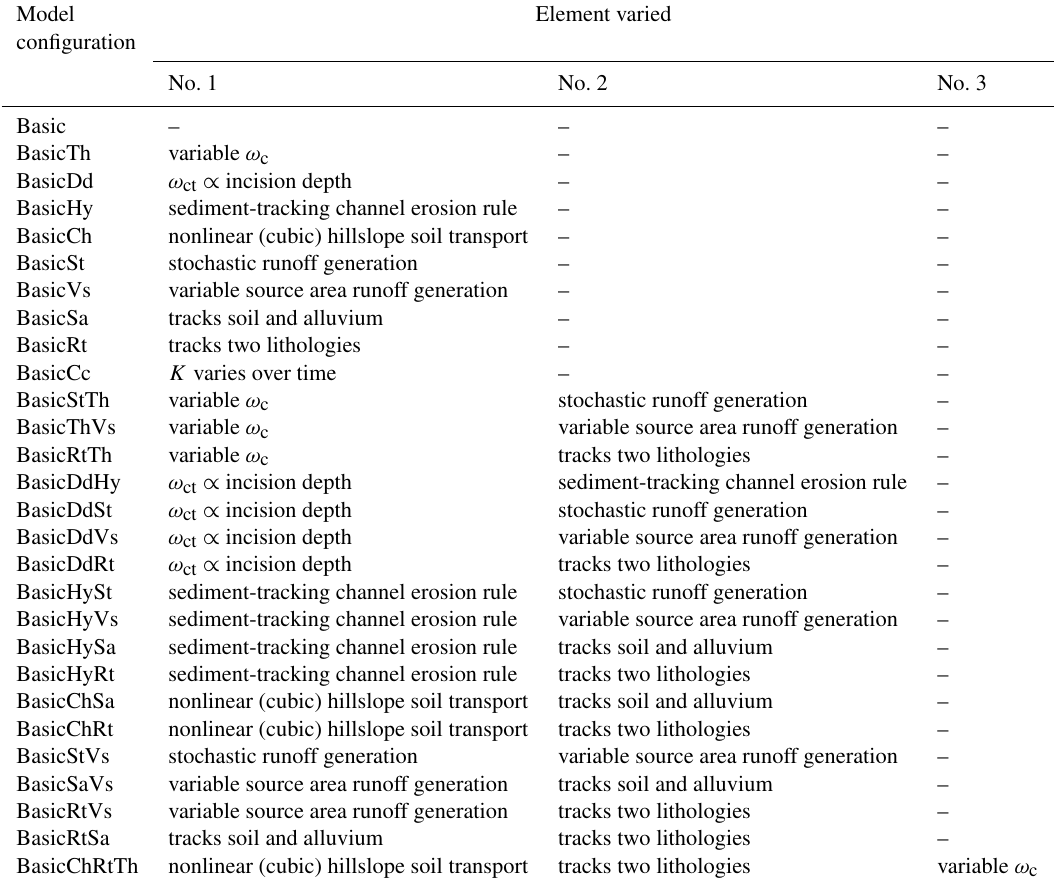
Table 2. Summary of 28 individual model programs in the terrainbento 1.0